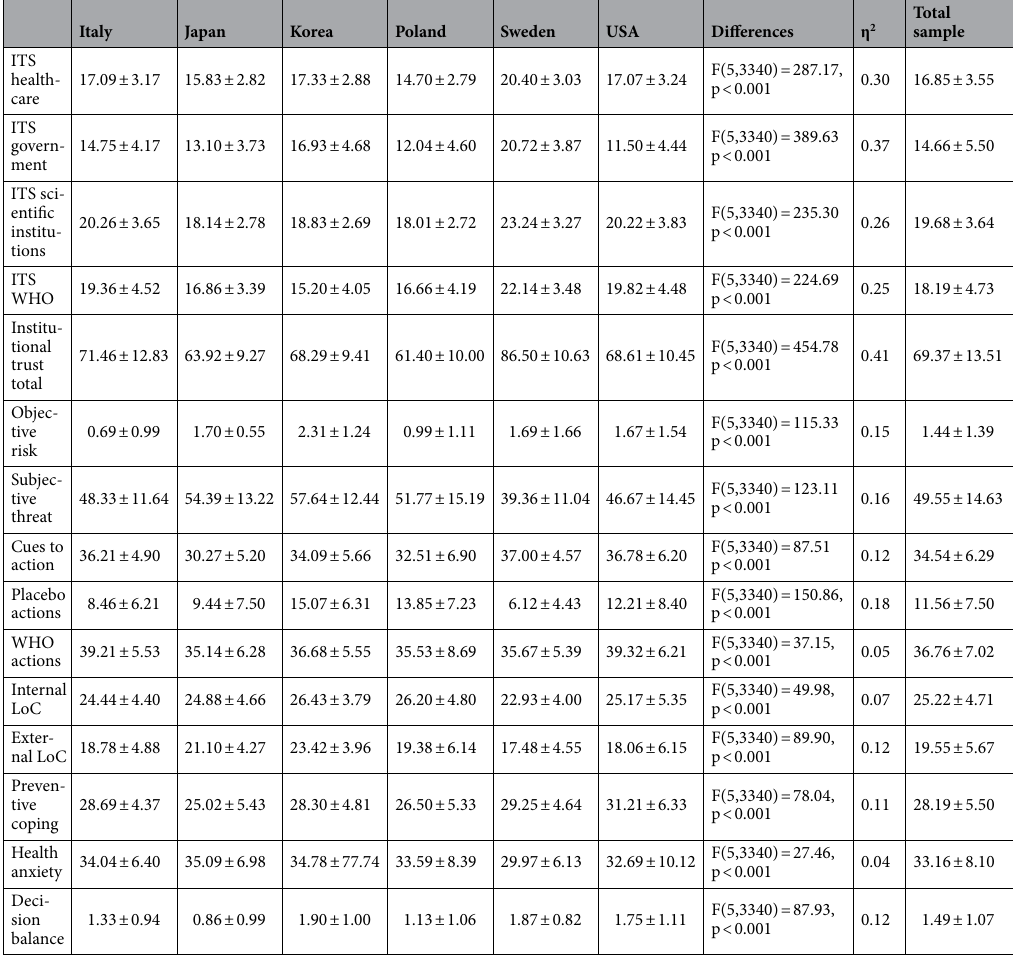
Table 1. Descriptive statistics (mean ± SD) and differences between countries. Total sample: N = 3346; Italy: N = 405, Japan: N = 190, Republic of Korea: N = 551, Poland: N = 1092, Sweden: N = 587, USA: N =